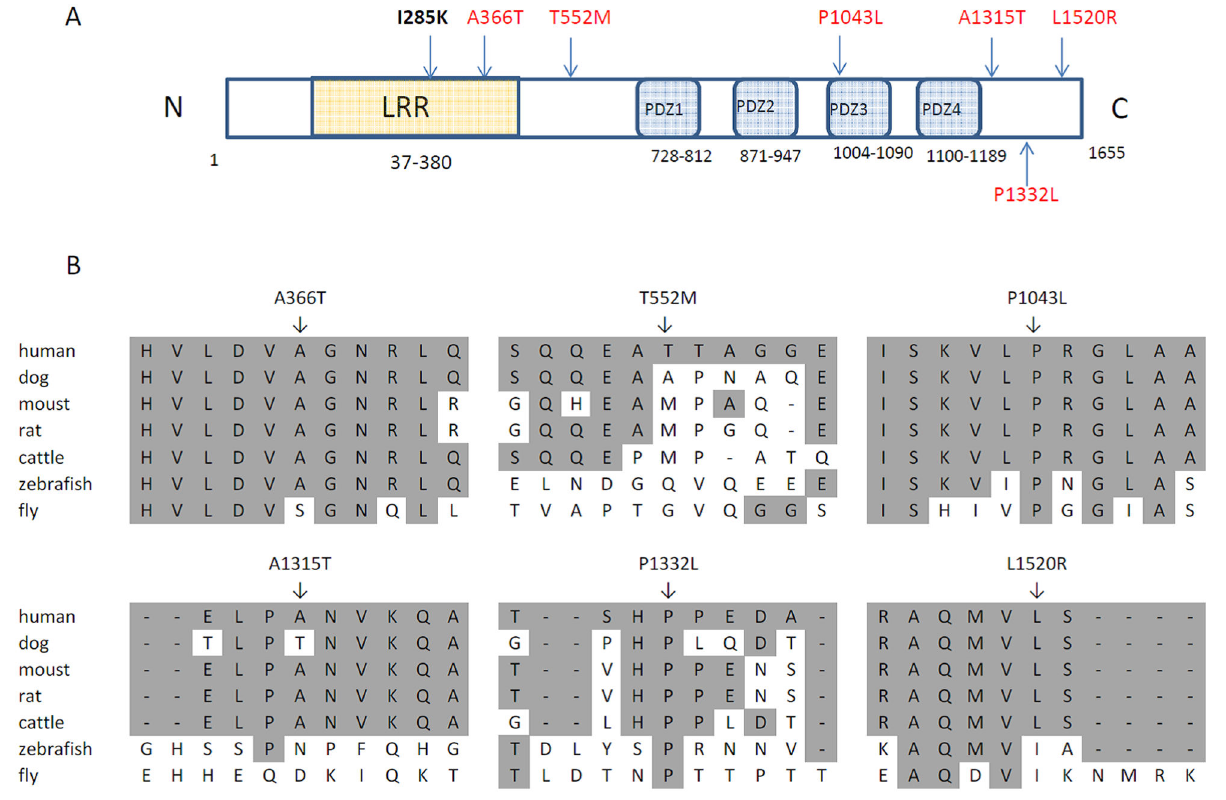
Figure 1. NTD specific SCRIB substitutions location and conservation analysis. (A) Location of missense changes and mouse mutations. (B) A partial alignment of SCRIB amino acid sequence between human and other vertebrates. The SCRIB variants found in NTDs affect conserved and less conserved residues. National Center for Biotechnology Information